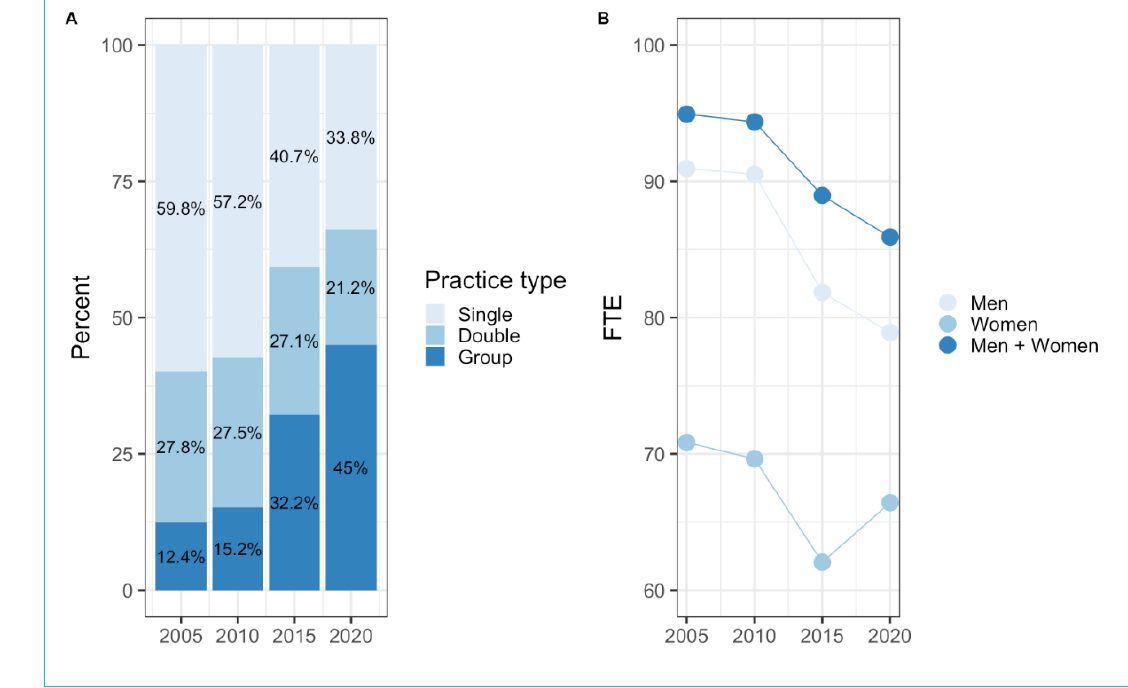
Figure 1: A: Proportion of practice types 2005–2020. B: Mean full-time equivalents (FTE) in men, women and both since